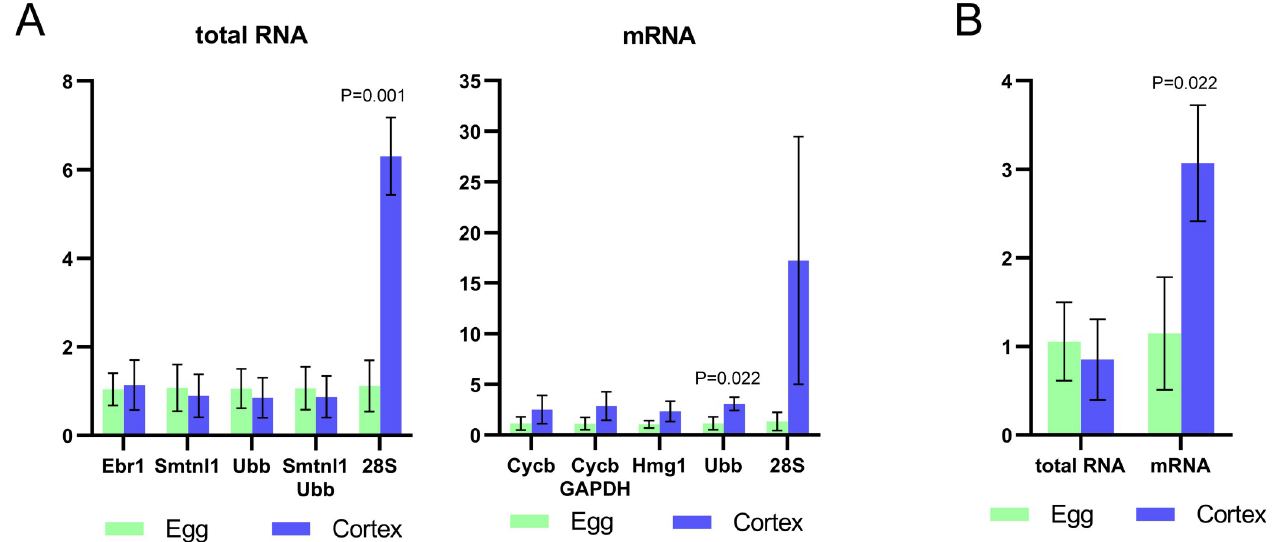
Fig 5. Comparison of the normalized relative levels of Daglb-2 between eggs and isolated cortices. (A) To normalize values, three most stable genes and best pair of genes were selected. Also, data were normalized to least stable gene (28S). (B) Relative levels of Daglb-2 normalized to Ubb . P-values indicate statistical significance between columns based on